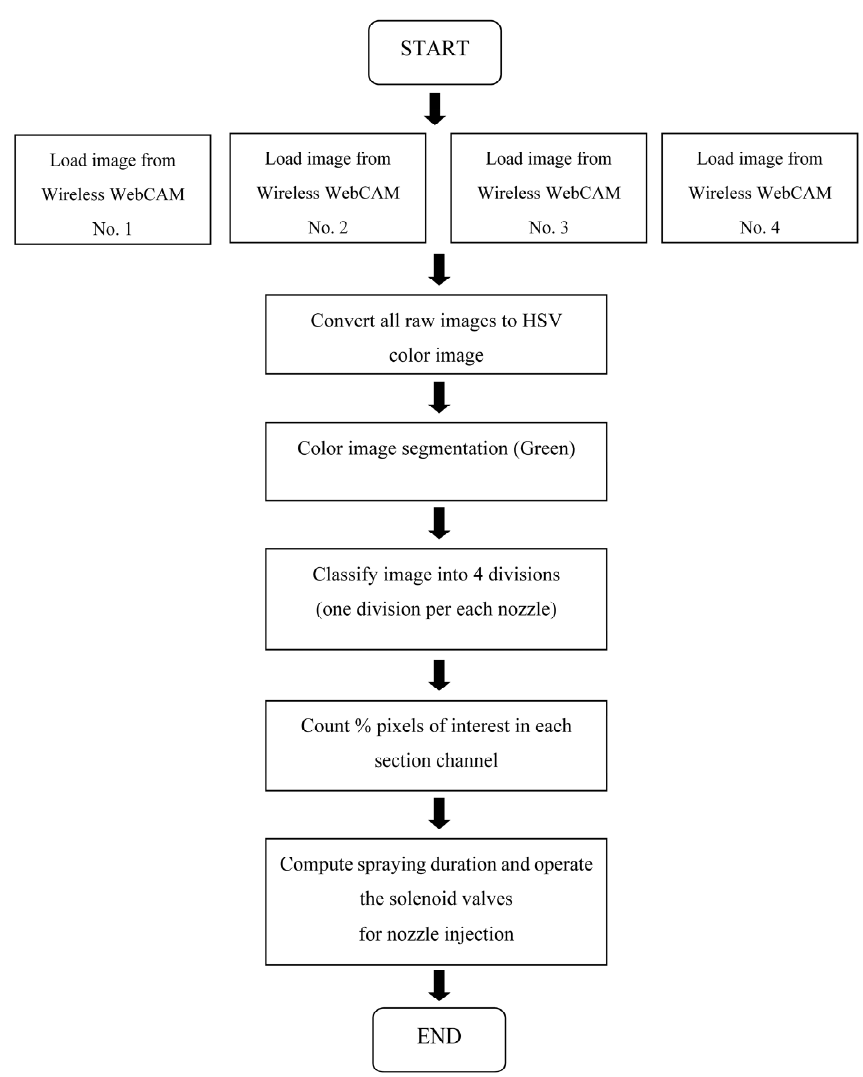
Figure 6. Functioning of the image processing software.